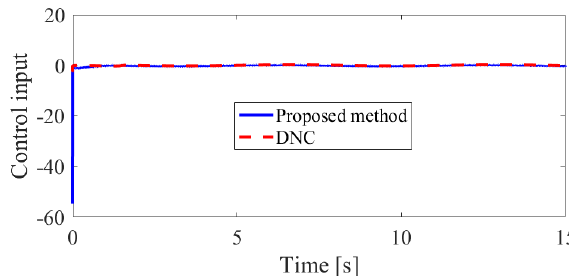
Figure 5. Convergence performance of e ς